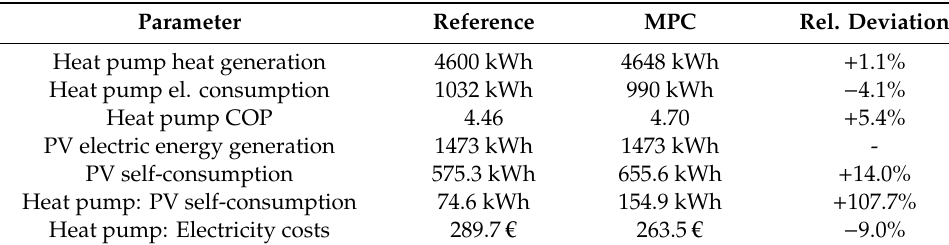
Table 1. Summary of experimental results.